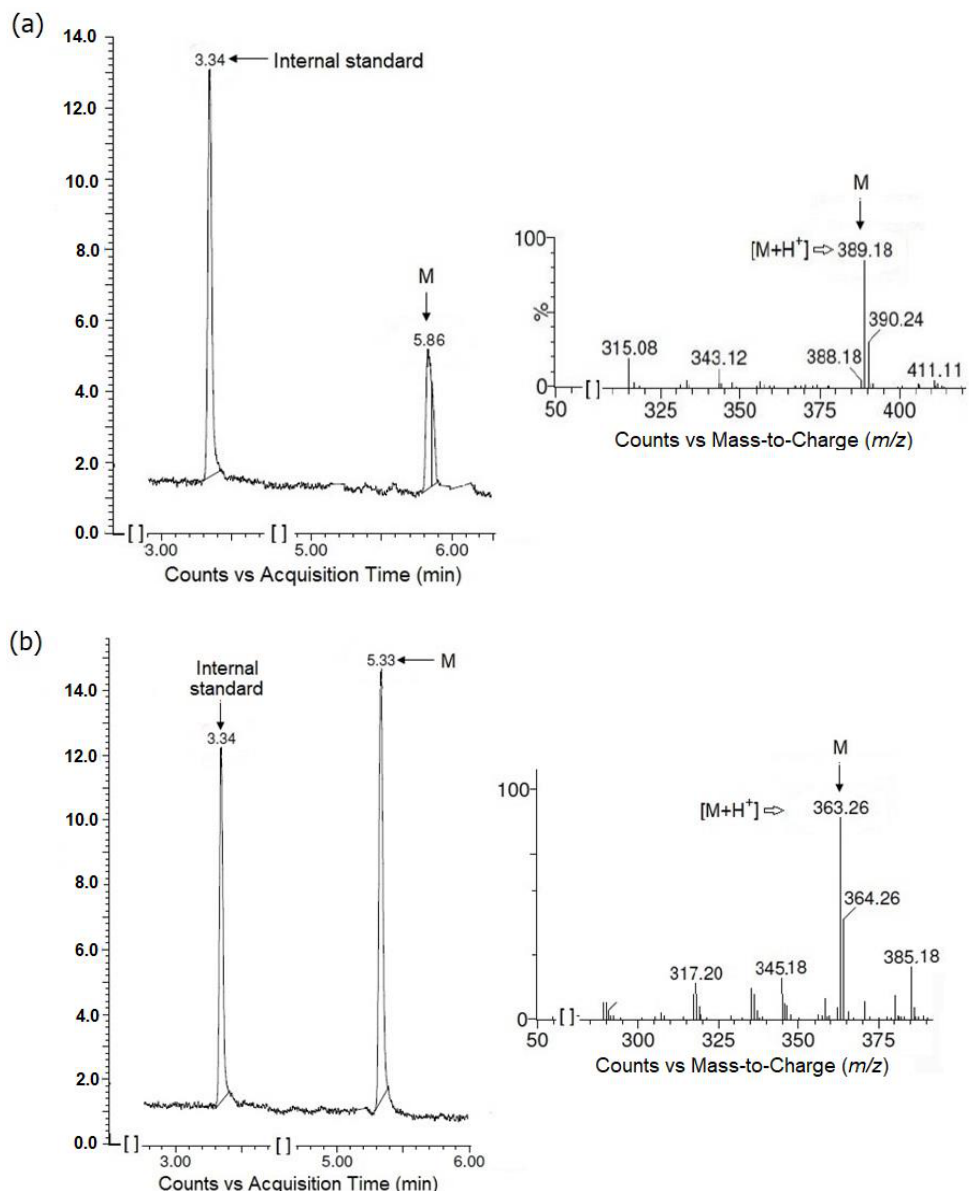
Figure 6. Formation of main metabolites (M) from JH3 ( a ) and JH10 ( b ) when test compounds were incubated with human liver microsomes (HLMs) without NADPH-regenerating system. Chromatograms and ion fragmentation (MS/MS) spectra for main metabolites are shown.